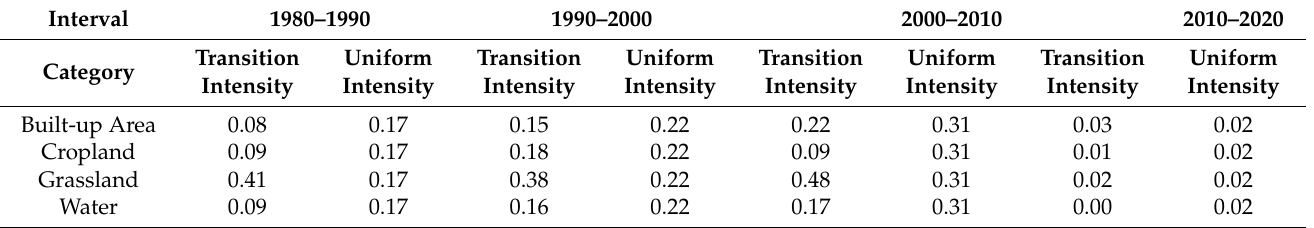
Table 21. Transition to Forest.